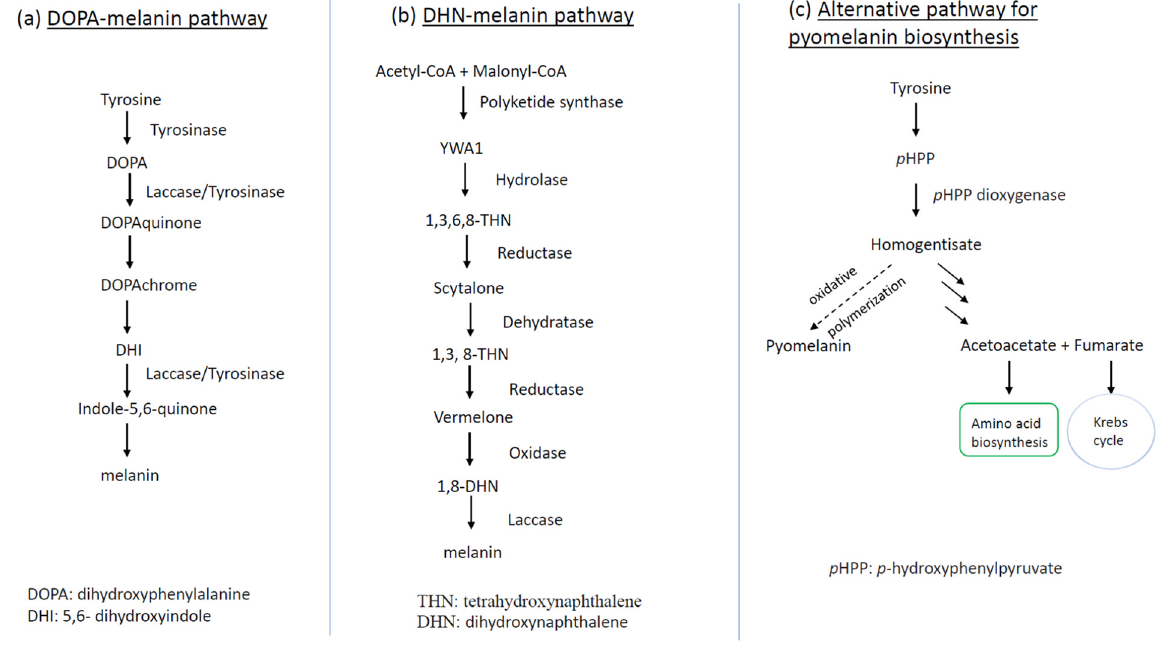
Figure 2. Schematic representation of fungal melanin biosynthetic pathways: ( a ) DOPA-melanin production route as shown in C. neoformans ; ( b ) biosynthetic pathway of DHN-melanin for deposit in conidial cell wall as manifested by A. fumigatus ; ( c ) alternative pathway of pyomelanin biosynthesis linked to conidial germination of A. fumigatus . The dotted line in ( c ) means that the step is active only during conidial germination. YWA1: Yellow pigment intermediate of WA polyketide synthase.